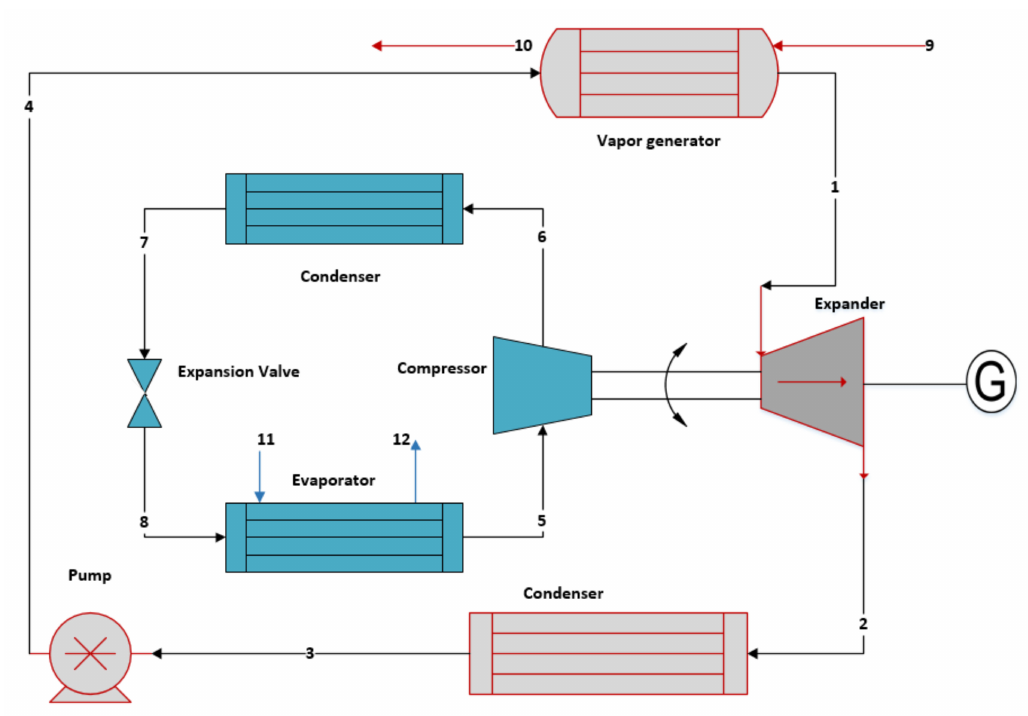
Figure 1. Schematic of the VCC derived from the basic